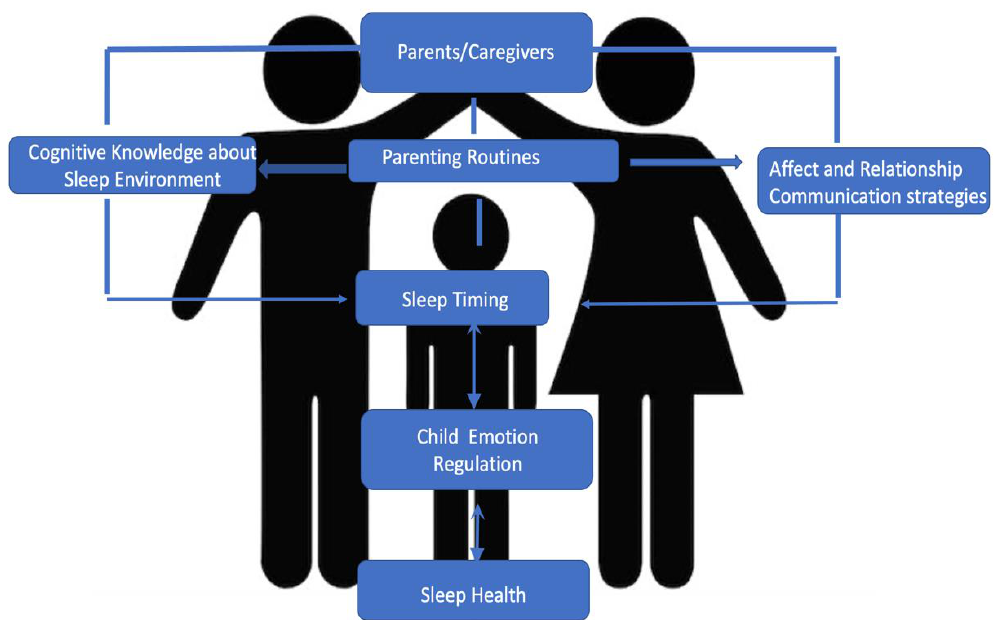
Figure 1. Theoretical framework guiding parent–child dyad sleep health in the family unit.